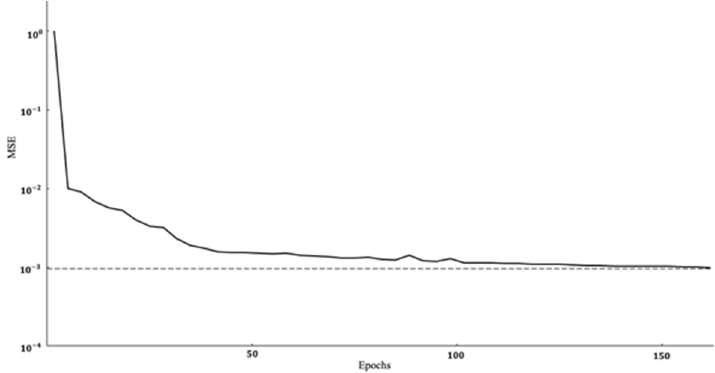
Figure 4. Convergence process of improved Elman neural network.